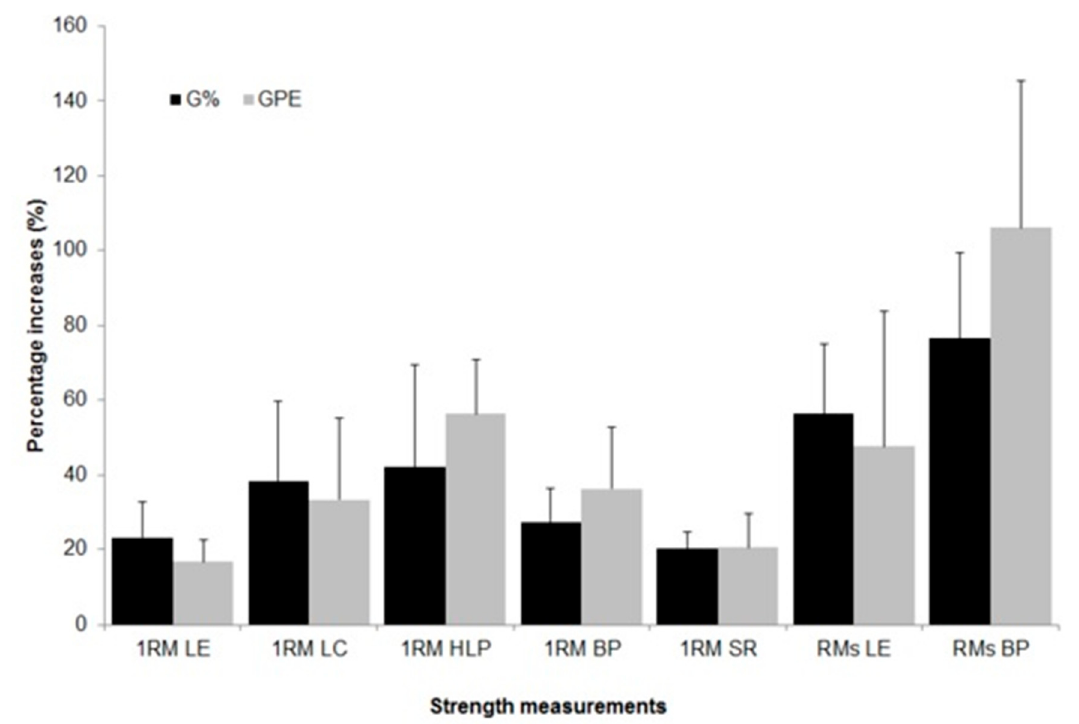
Figure 3. Percentage changes in maximum dynamic strength tests (1RM) and muscular endurance tests (RMs) for leg extension (LE), leg curl (LC), horizontal leg press (HLP), bench press (BP), and seated row (SR), in both training groups (G% and GPE).